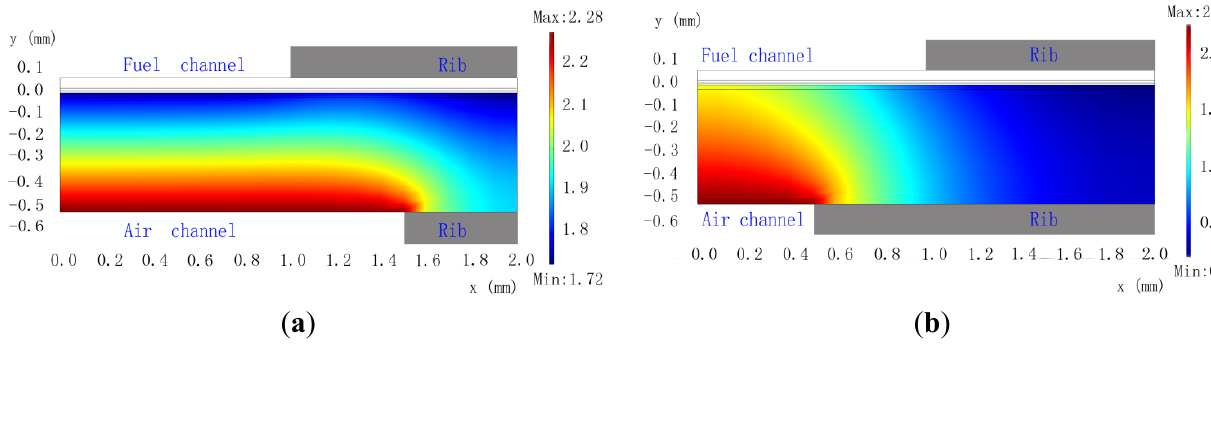
Figure 4. Distributions of O